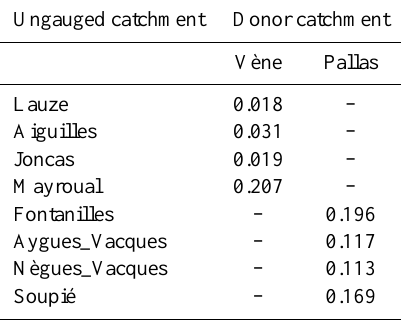
Table 5. Measure of the ASRIL factor of the predicted FDC uncer- tainty intervals in the ungauged